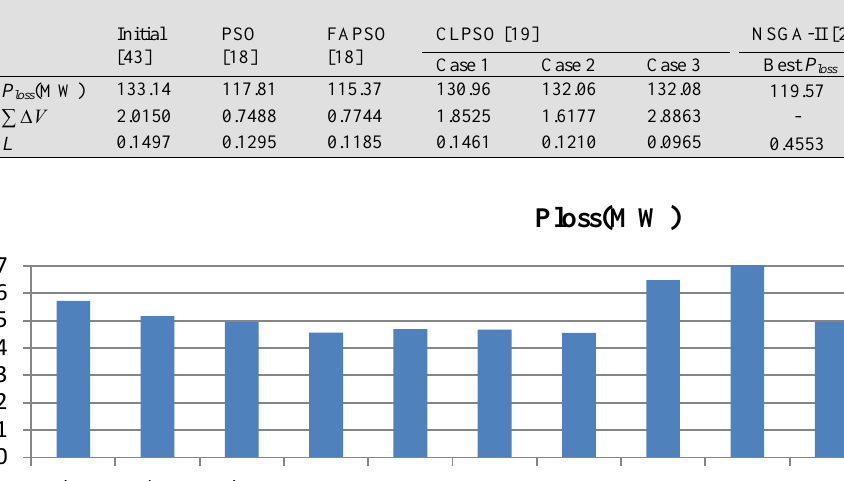
Table 6.The results of POPSO and comparison with other methods on IEEE 118-bus test system